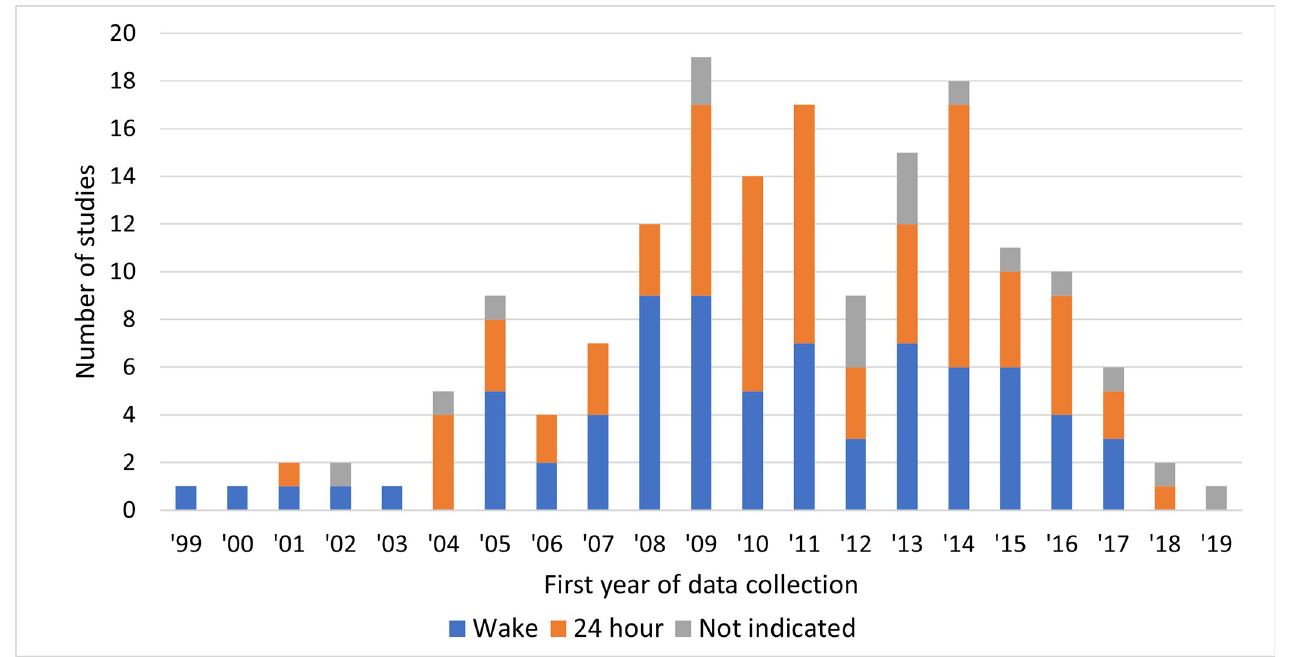
Fig 4. Wear protocol by first year of data collection, graphed at the accelerometer level (n = 166).